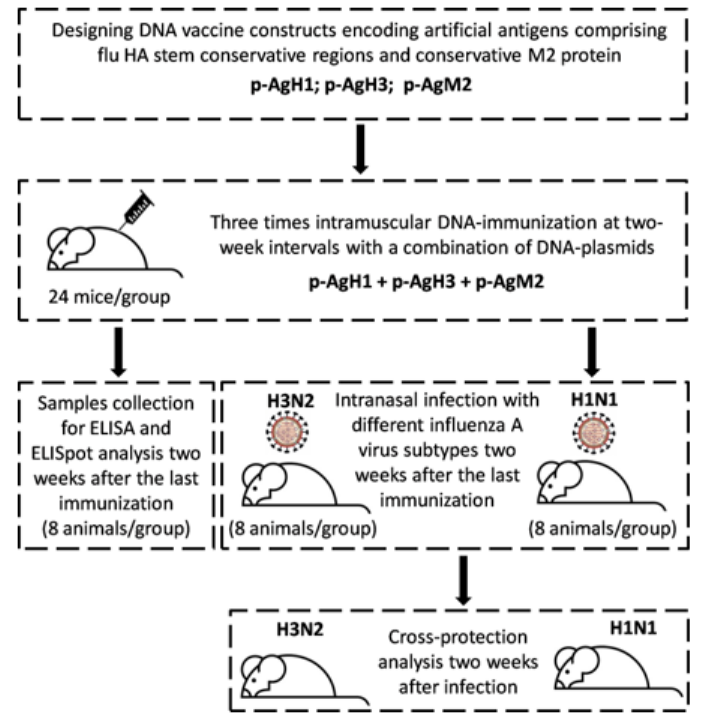
Figure 1. Flow diagram for the conducted animal experiment.